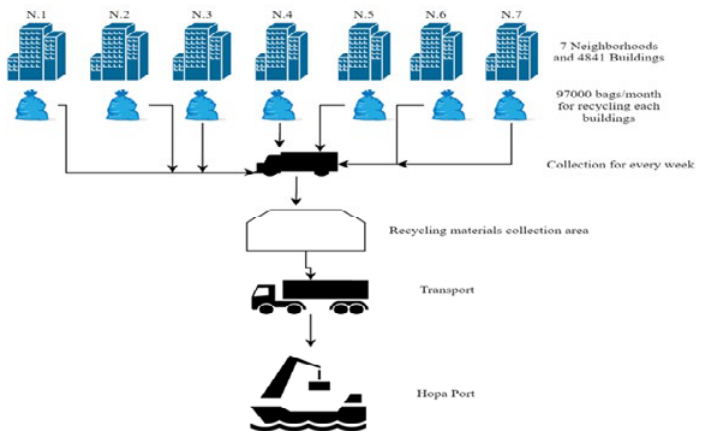
Fig. 11: Method CFB flow chart